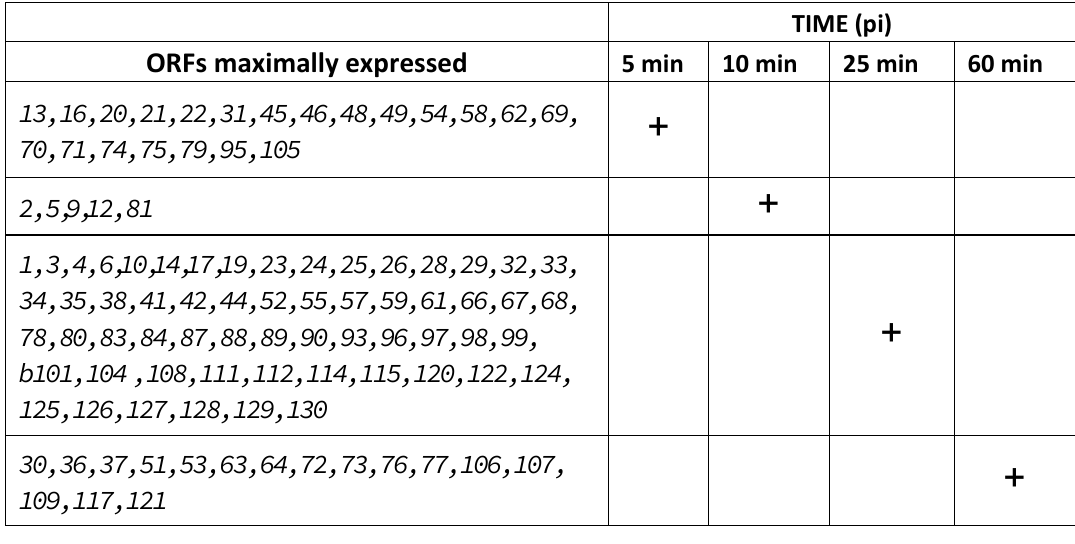
Table 3. Felix O1 transcription analysis showing the genes maximally expressed early (5 min), delayed early (10 min), middle (25 min) and late (60 min) after infection (pi) of S . Typhi with phage Felix